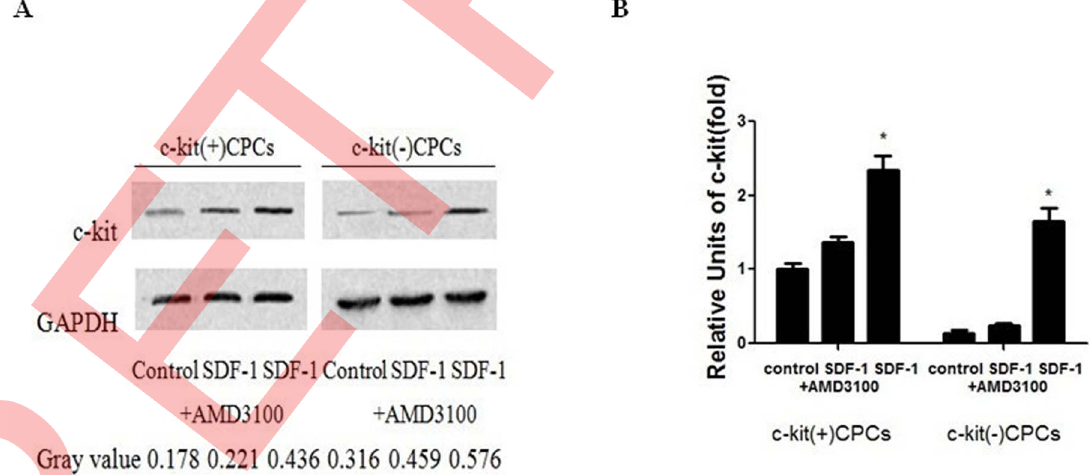
Figure 2. SDF-1 a up-regulation on the expression of c-kit. (A) CPCs were stimulated with 100 ng/ml SDF-1 a and 5 m g/ml AMD3100 for 48 h. Western blotting was performed to analyze the protein expressions of c-kit and GAPDH. (B) qPCR was performed to analyze the mRNA expression of c-kit. Data were obtained from three independent experiments and expressed as mean 6 SD. n=3. * P , 0.05 versus the control group.